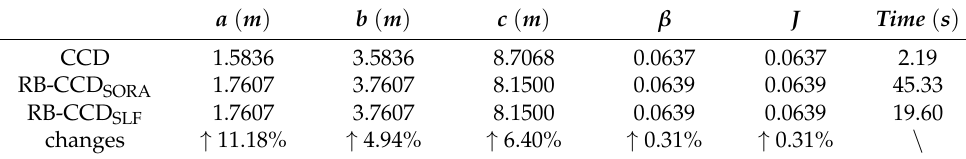
Table 2. The results of CCD and RB-CCD for the glider dynamic soaring system.